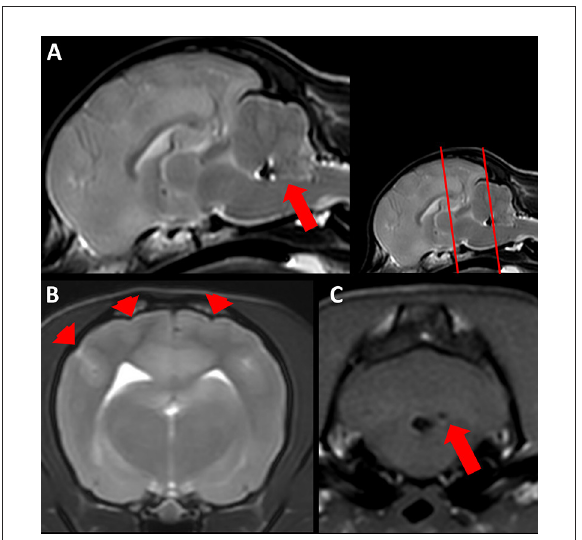
FIGURE1 Magnetic resonance imaging (MRI) of a 1.25 year old Chihuahua (case 1). (A) Sagittal T2 weighted (w) post mortem MRI of the brain. Note the mild indentation of the rostral cerebellum due to increased volume of the cerebrum. Hypointense material fills the fourth ventricle (arrow), intraventricular hemorrhage is suspected. (B) Transversal T2w MRI of the cerebrum at the level of the caudal part of the hippocampus (level is indicated in the small inlay as the first red line). Note the generalized swelling of gray matter with flattened gyri and sulci (arrowheads). (C) Transversal T1w MRI of the cerebellum and brainstem (level is indicated in the small inlay as the second red line). Round, well demarcated intraaxial lesion with signal void (arrow), hemorrhage is